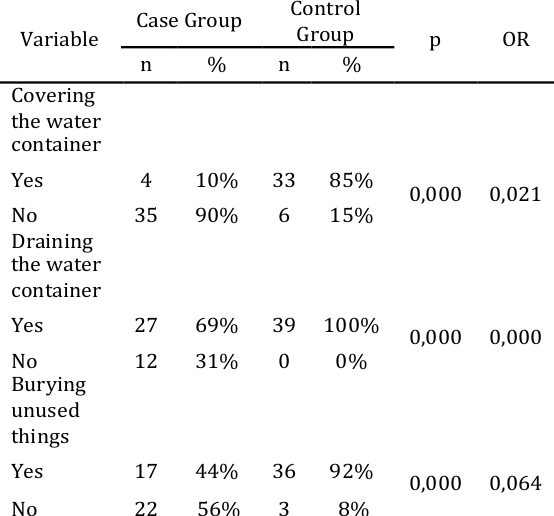
Table 2. Relationship between the 3M Behavior